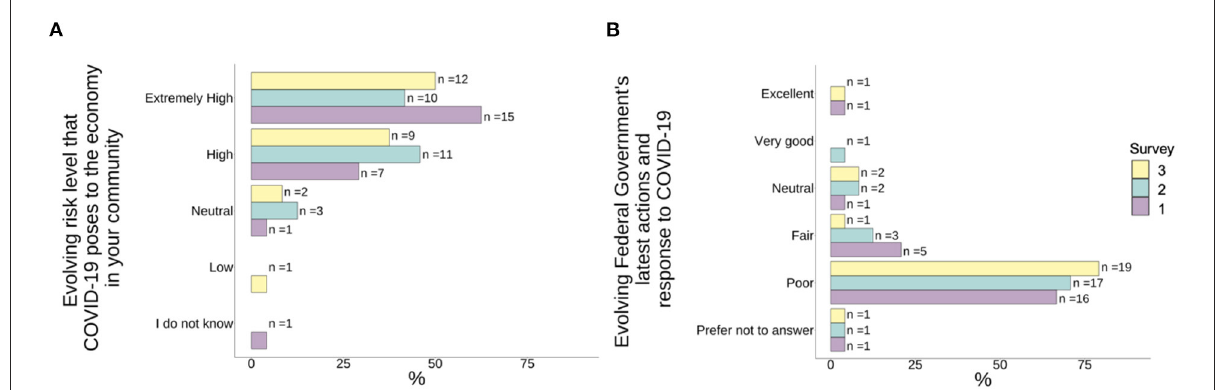
FIGURE6 Civic scientists’ evolving rating of: (A) risk level that the COVID-19 pose to the community/financial situation in their community and (B) the Federal Government’s latest actions and responses to